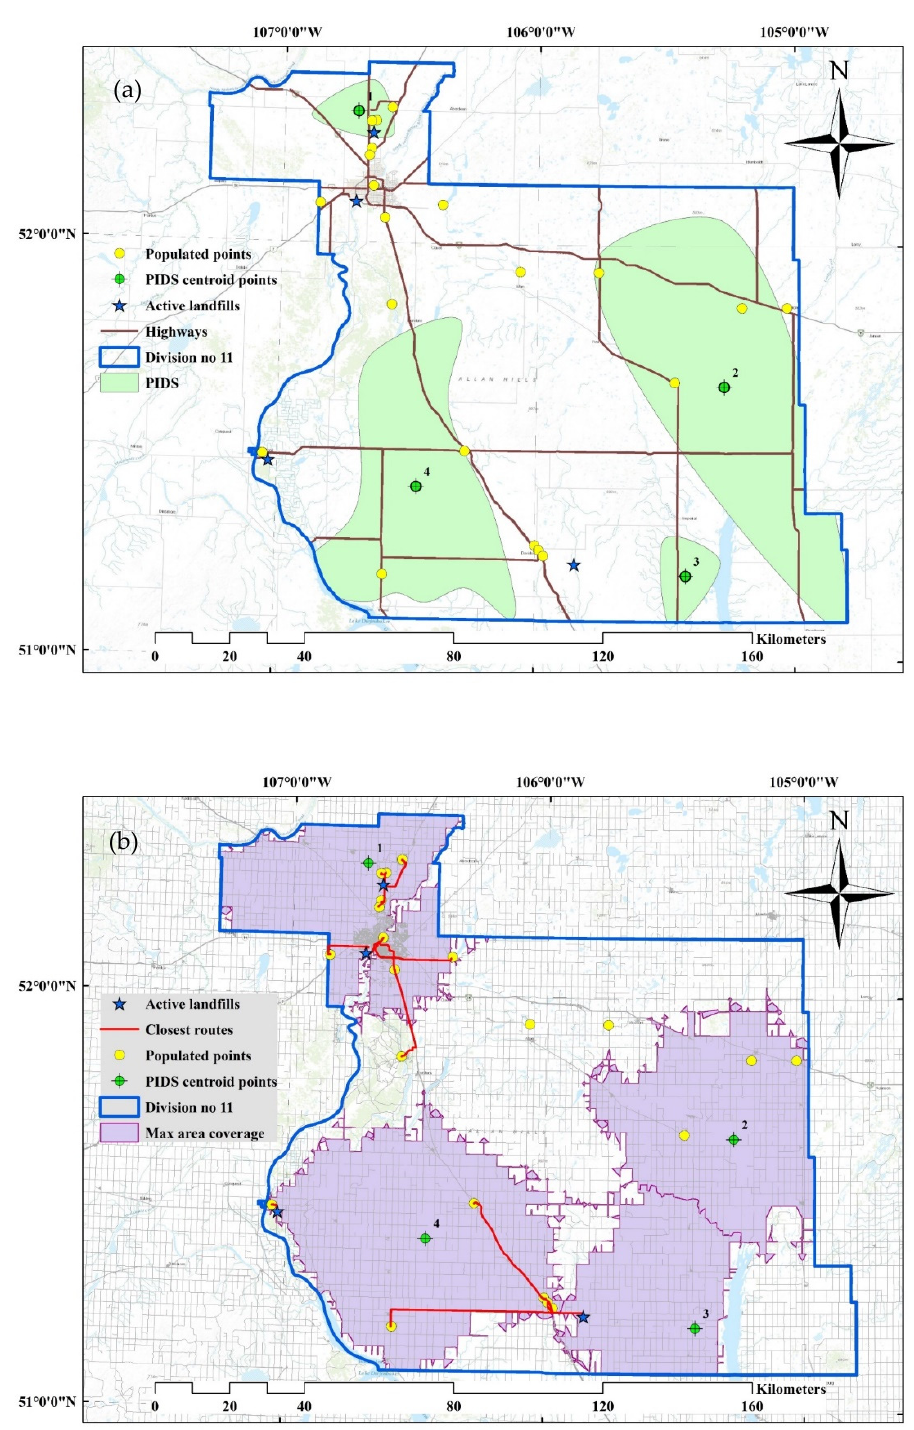
Figure 3. ( a ) A PIDS map of the study area; ( b ) AC map in Saskatchewan, Canada.